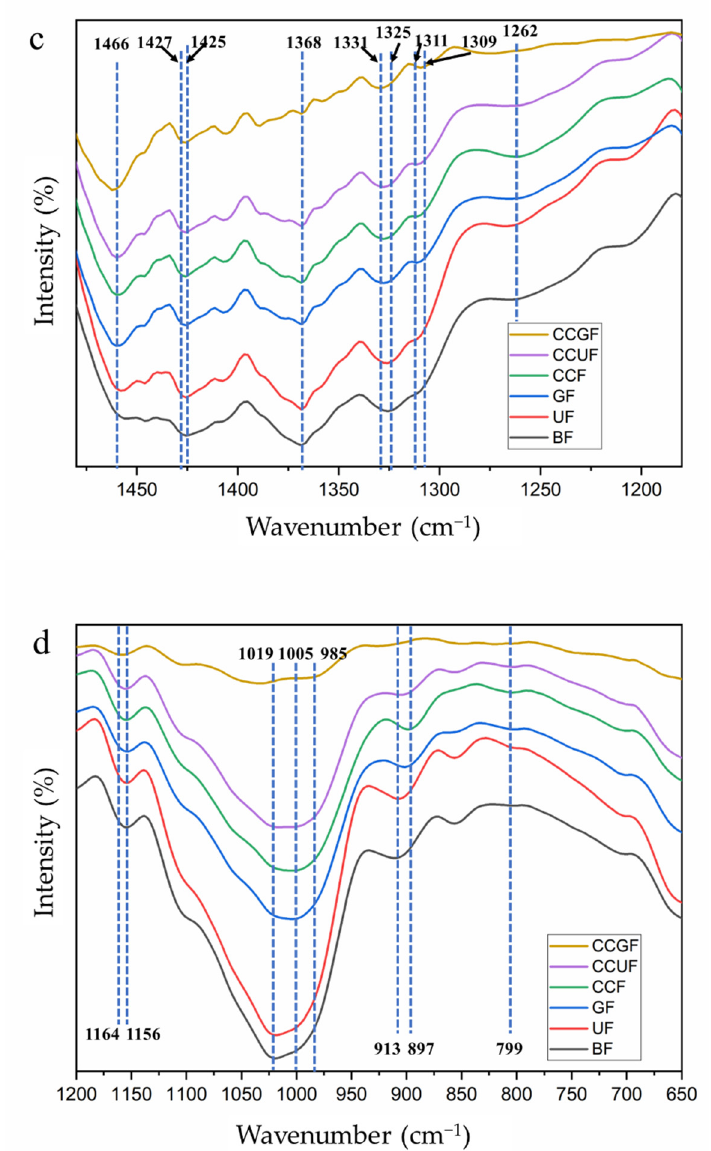
Figure 5. FT-IR spectra of the regenerated cellulose fibers with or without additives: ( a ) FT-IR spectra of the wavenumber at 4000~600 cm − 1 ; ( b ) FT-IR spectra of the wavenumber at 3800~2650 cm − 1 ; ( c ) FT-IR spectra of the wavenumber at 1500~1150 cm − 1 ; ( d ) FT-IR spectra of the wavenumber at 1200~650 cm − 1 . Table 3. Assignment of FT-IR spectra of the regenerated cellulose fibers with or without additives. Wavenumber (cm − 1 ) Bond and Functional